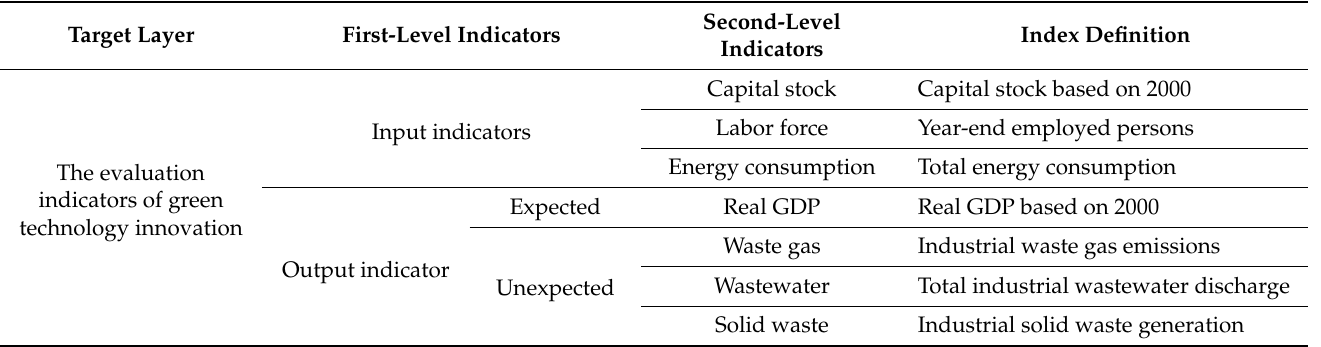
Table 1. The evaluation indicators of